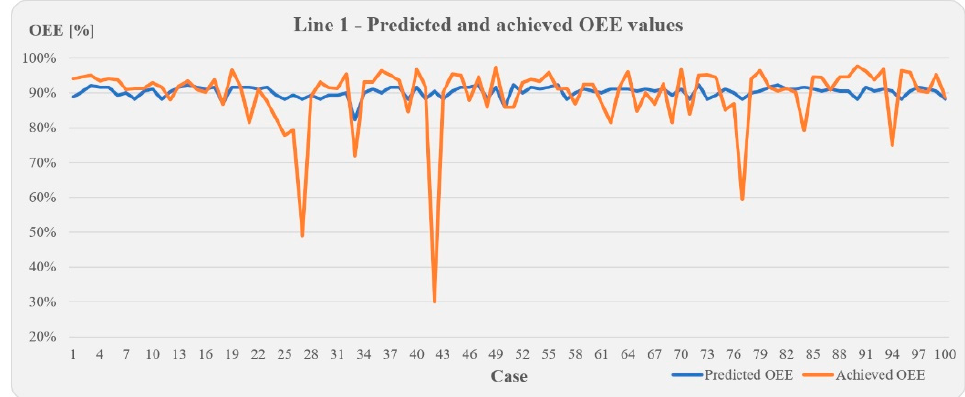
Figure 2. Predicted and achieved OEE values for assembly line 1.